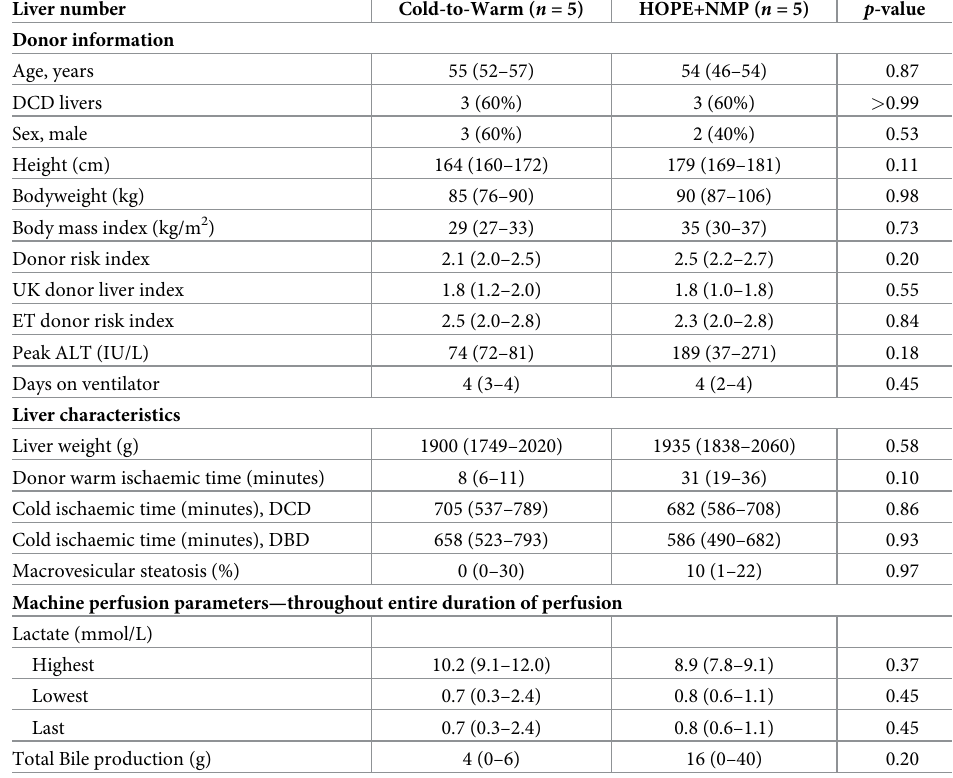
Table 2. Donor demographics, liver characteristics and machine perfusion